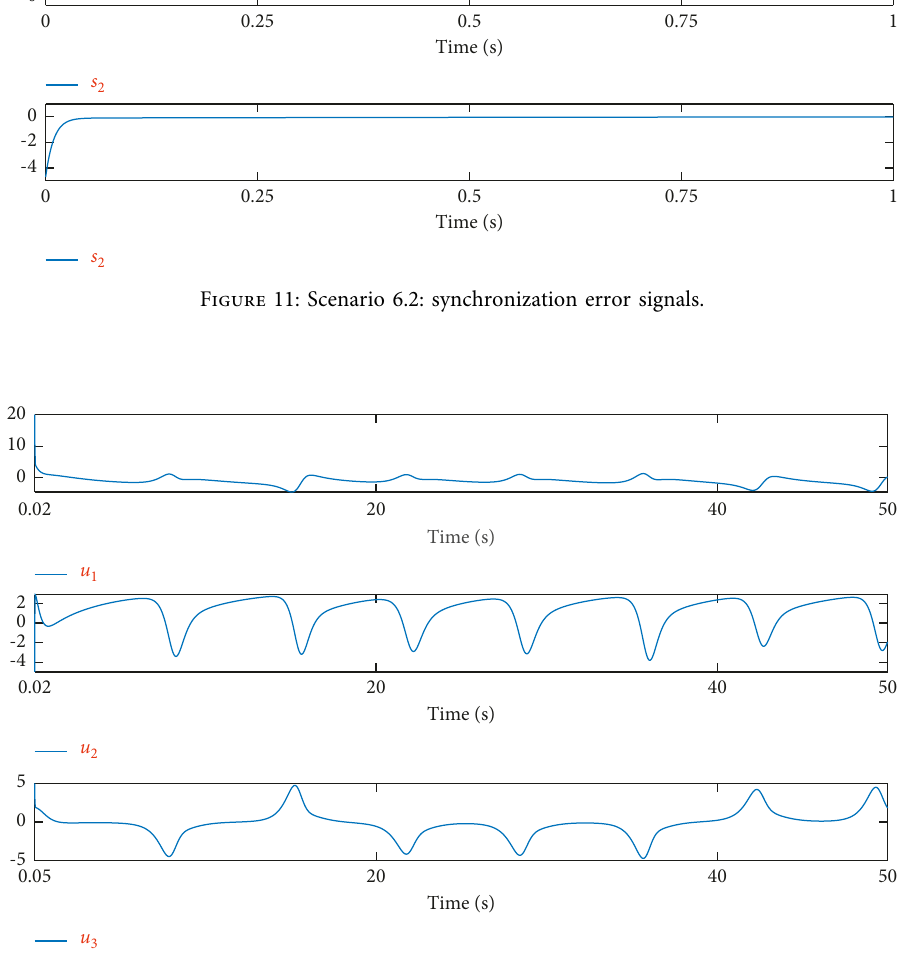
Figure 12: Scenario 6.2: control